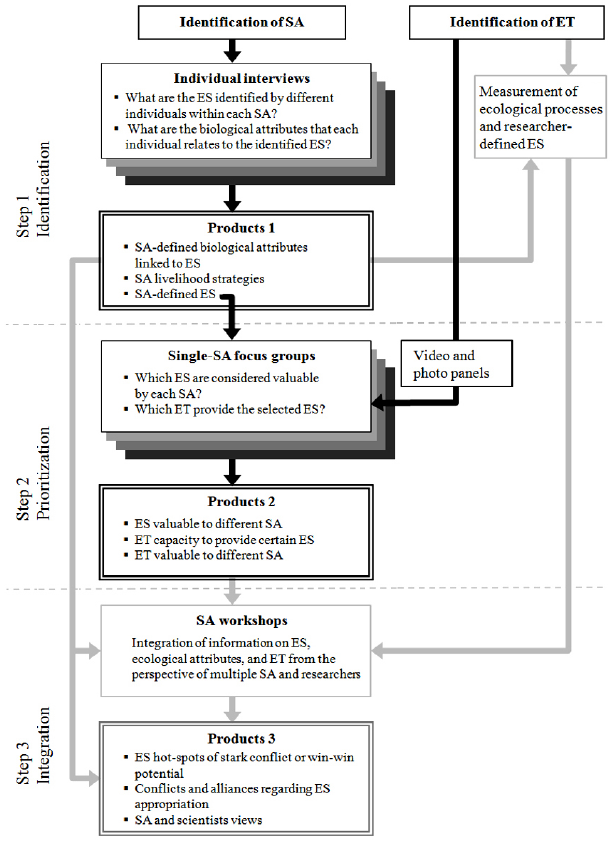
valuation of ES, by focusing on the interests and strategies of Fig. 1 . Summary of the methodology presented (in black) within the framework of the broader methodology proposed by Díaz et al. (2011). The grey arrows and boxes are part of the methodology proposed by Díaz et al. (2011) but are not developed in the present article. Double-line boxes represent salient products of each step (for a more complete list of potential products see Table 1). Overlapping boxes in different shades of grey symbolize activities carried out in parallel with different social actors (SA). Step 1 focuses on the interdisciplinary identification of both SA and ecosystem types (ET), and on interviewing a wide range of individuals within each SA. Its main products (Products 1) are a list of ecosystem services (ES) identified by all interviewees, and detailed narratives of their perceived links with biodiversity and ecosystem properties. This list of ES and interdisciplinarily produced video and photo panels of the six ecosystem types are essential inputs to the next step. Step 2 consists of parallel, single SA focus groups. Its main products (Products 2) are SA priorities in terms of ES and the ecosystem types that can provide them. For steps not covered in this article, see Díaz et al. (2011), in which matrices and nonvectorial information represented by E and F of their Figure 3 are included in the Products 2 box, and matrix G is included in Products 3 box.